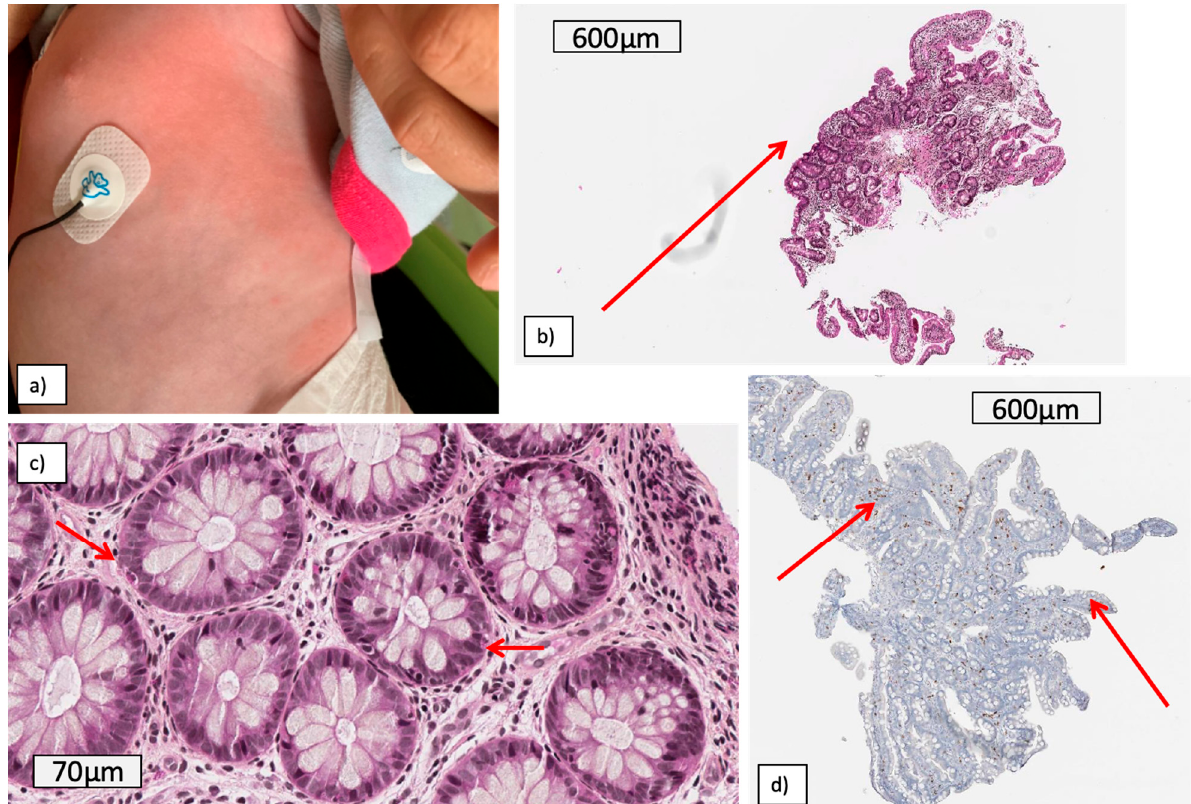
Figure 1. Skin rash ( a ) and gastrointestinal lesions ( b – d ) of patient 1: ( b ) duodenum: total to subtotal focal villous atrophy, ( c ) colon intraepithelial eosinophilic infiltrate, ( d ) duodenum: CD8 immunostaining: no increased intraepithelial lymphocytes (CD8).